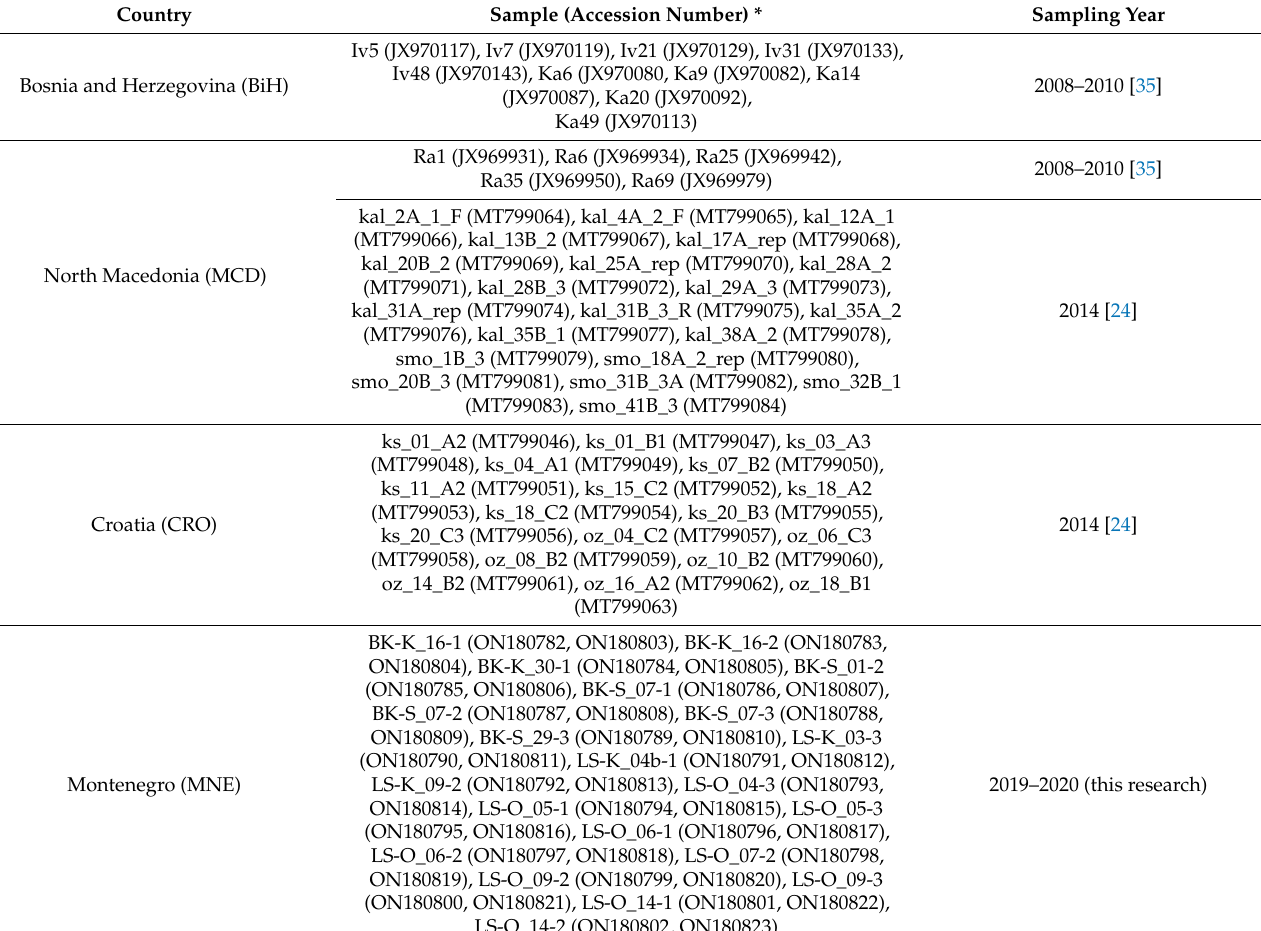
Table 1. Cryphonectria hypovirus 1 (CHV1) sequences and their accession numbers used in this